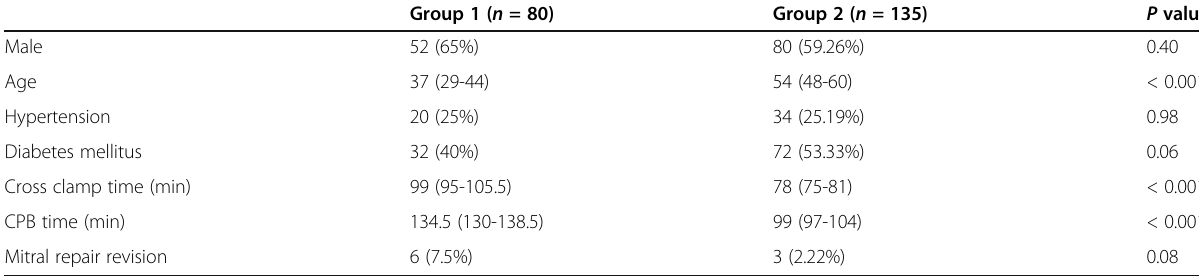
Table 1 Preoperative and operative